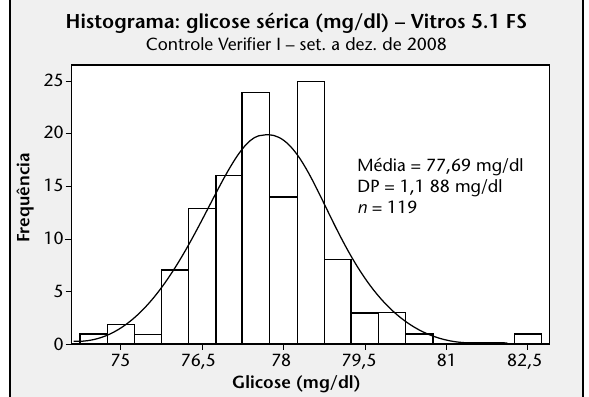
Figura 1 – Análise de imprecisão de longo prazo: histograma da amostragem de controles internos (Verifier I), glicose Vitros FS 5.1, setembro a dezembro de 2008 ( n = 119) DP: desvio